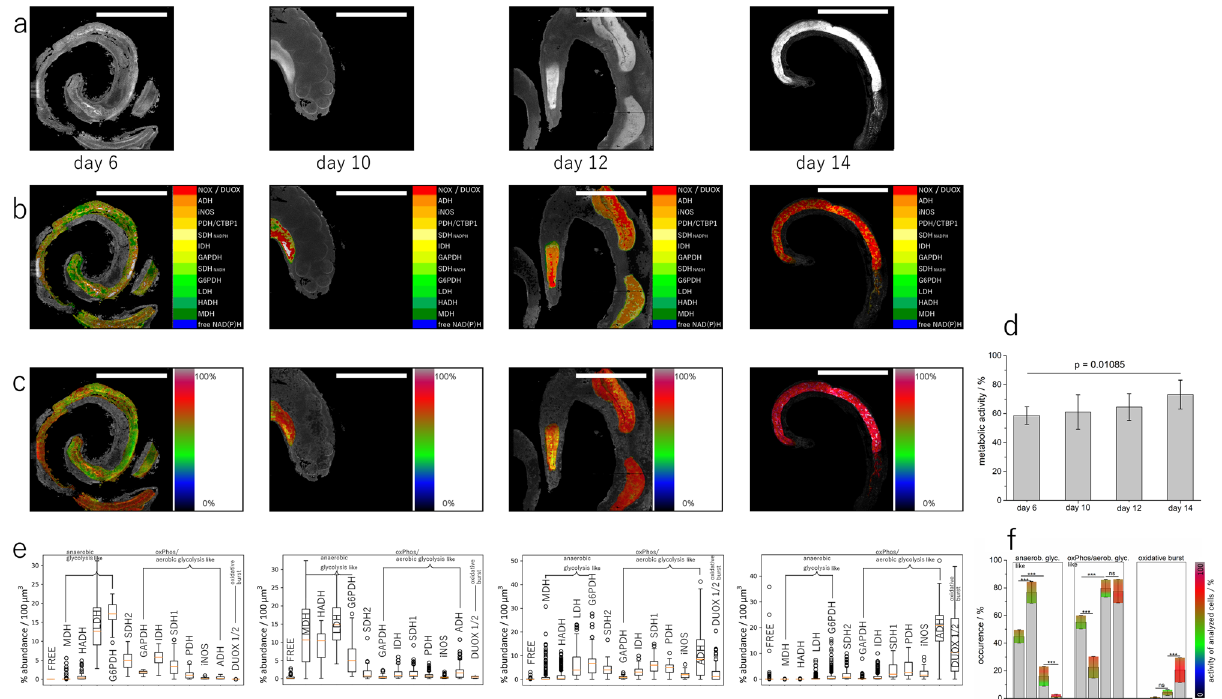
Figure 5. NAD(P)H metabolism of H. polygyrus over the course of infection. (a) Representative masked NAD(P)H fluorescence sum images (500 × 500 × 100 µm 3 ) of NAD(P)H-rich parasite compartments at day 6, 10, 12 and 14 after infection and corresponding enzyme activity maps (b) and activity maps (c) . Scale bar = 250 µm. (d) Metabolic activity graph in parasites, at the same time points (n = 2 worms, day 6; n = 5 worms for day 10; n = 4 worms, day 12; n = 5 worms, day 14). (e) Corresponding frequency graphs of enzymatic activity for the same parasites as in (d) . (f) Pixel frequencies of anaerobic glycolysis-like pathways, oxidative phosphorylation (oxPhos)/aerobic glycolysis-like pathways and oxidative burst, all given in percentage, encompassing all nematodes in (d) . The superimposed false color bar for each column indicates the corresponding general metabolic activity per pixel, in percent. Statistical analysis in (f) was performed using ANOVA test with Bonferroni multi-column post-test (ns p > 0.05, *p < 0.05, **p < 0.01, ***p < 0.001). Figure generated with Paint. NET, https:// www. getpa int. net/ downl oad.